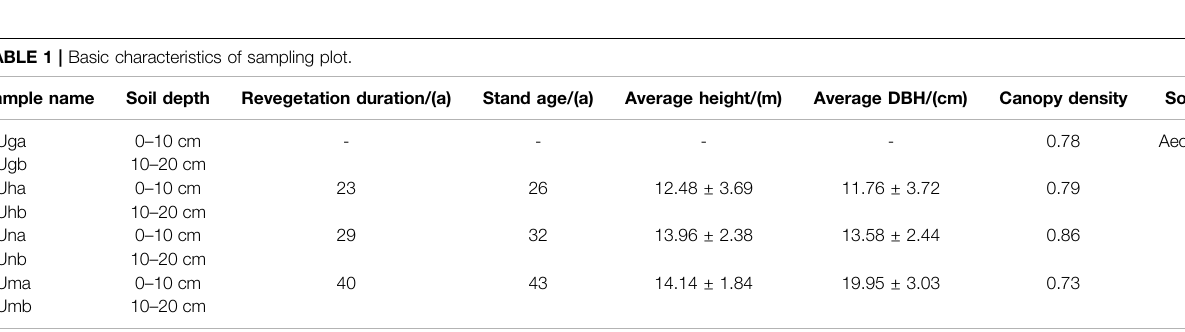
TABLE 1 | Basic characteristics of sampling